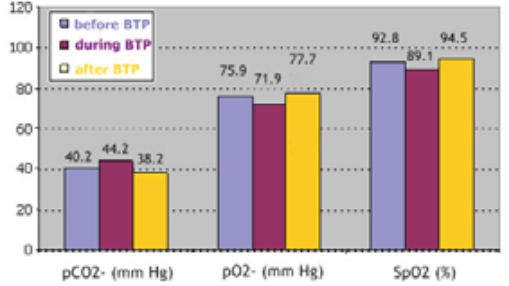
FIGURE 3. The mean of respirations per minute depending on the number of BTP